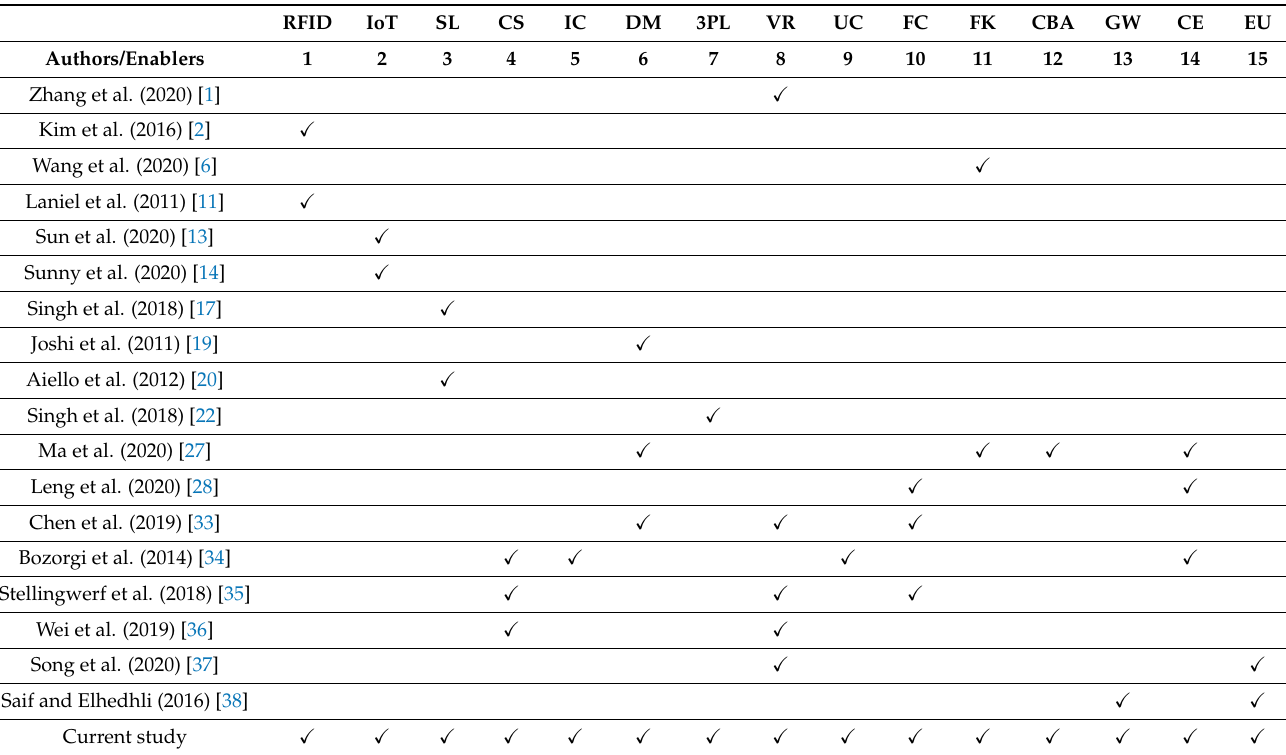
Table 2. Summary of literature review for enablers of PFSC.